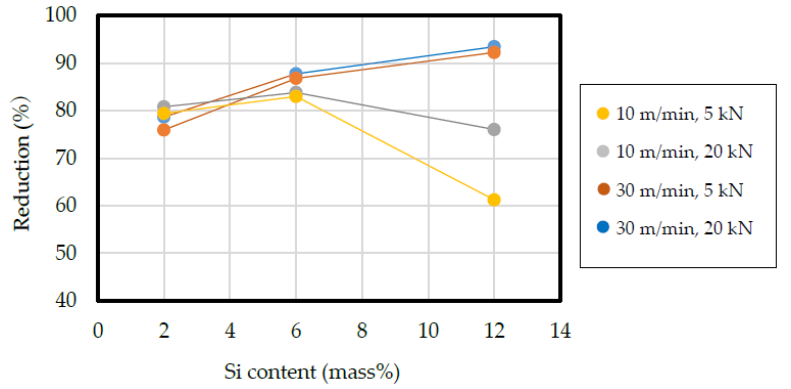
Figure 11. Reduction calculated from solidification starting positions and strip thicknesses. Roll speed: 10 m/min and 30 m/min; roll load: 5 kN and 20 kN; Si content: 2%, 6%, and 12%.